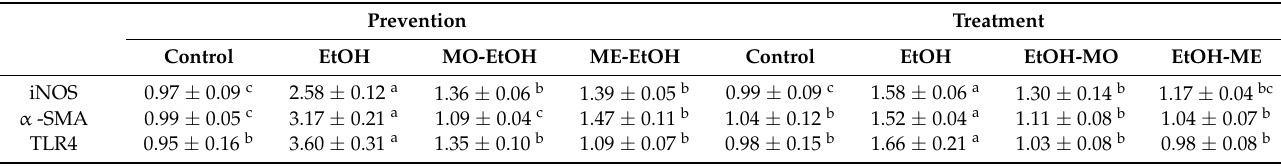
Table 8. Effect of myrrh oil and myrrh extract on the relative expression of iNOS, α -SMA, and TLR4. Prevention